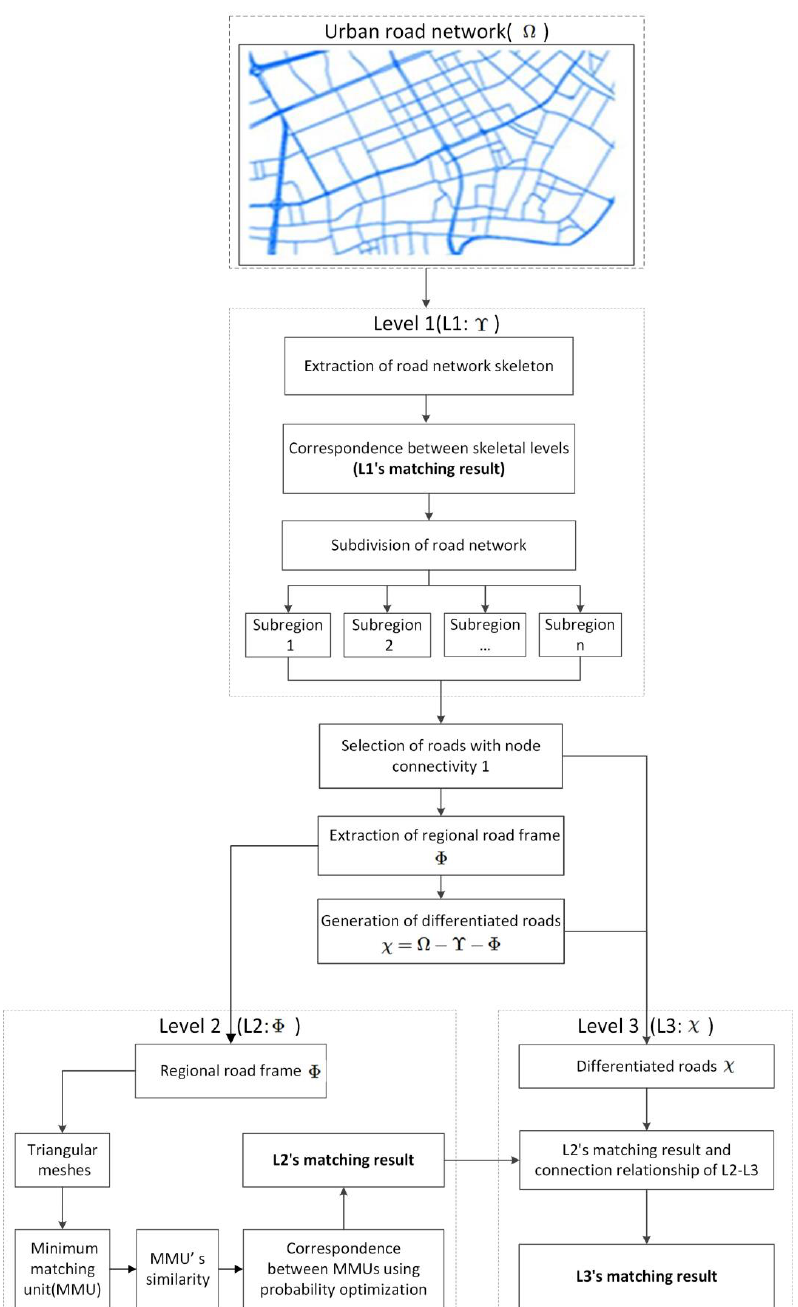
Figure 1. Hierarchical matching framework for road networks by using constrained Delaunay triangulation (CDT).